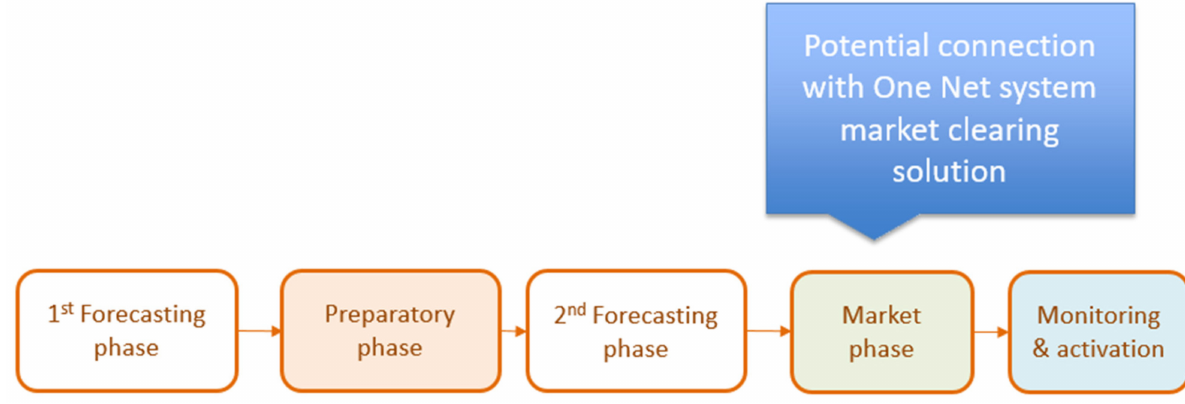
Figure 14. Clearing solution of the OneNet Market in the